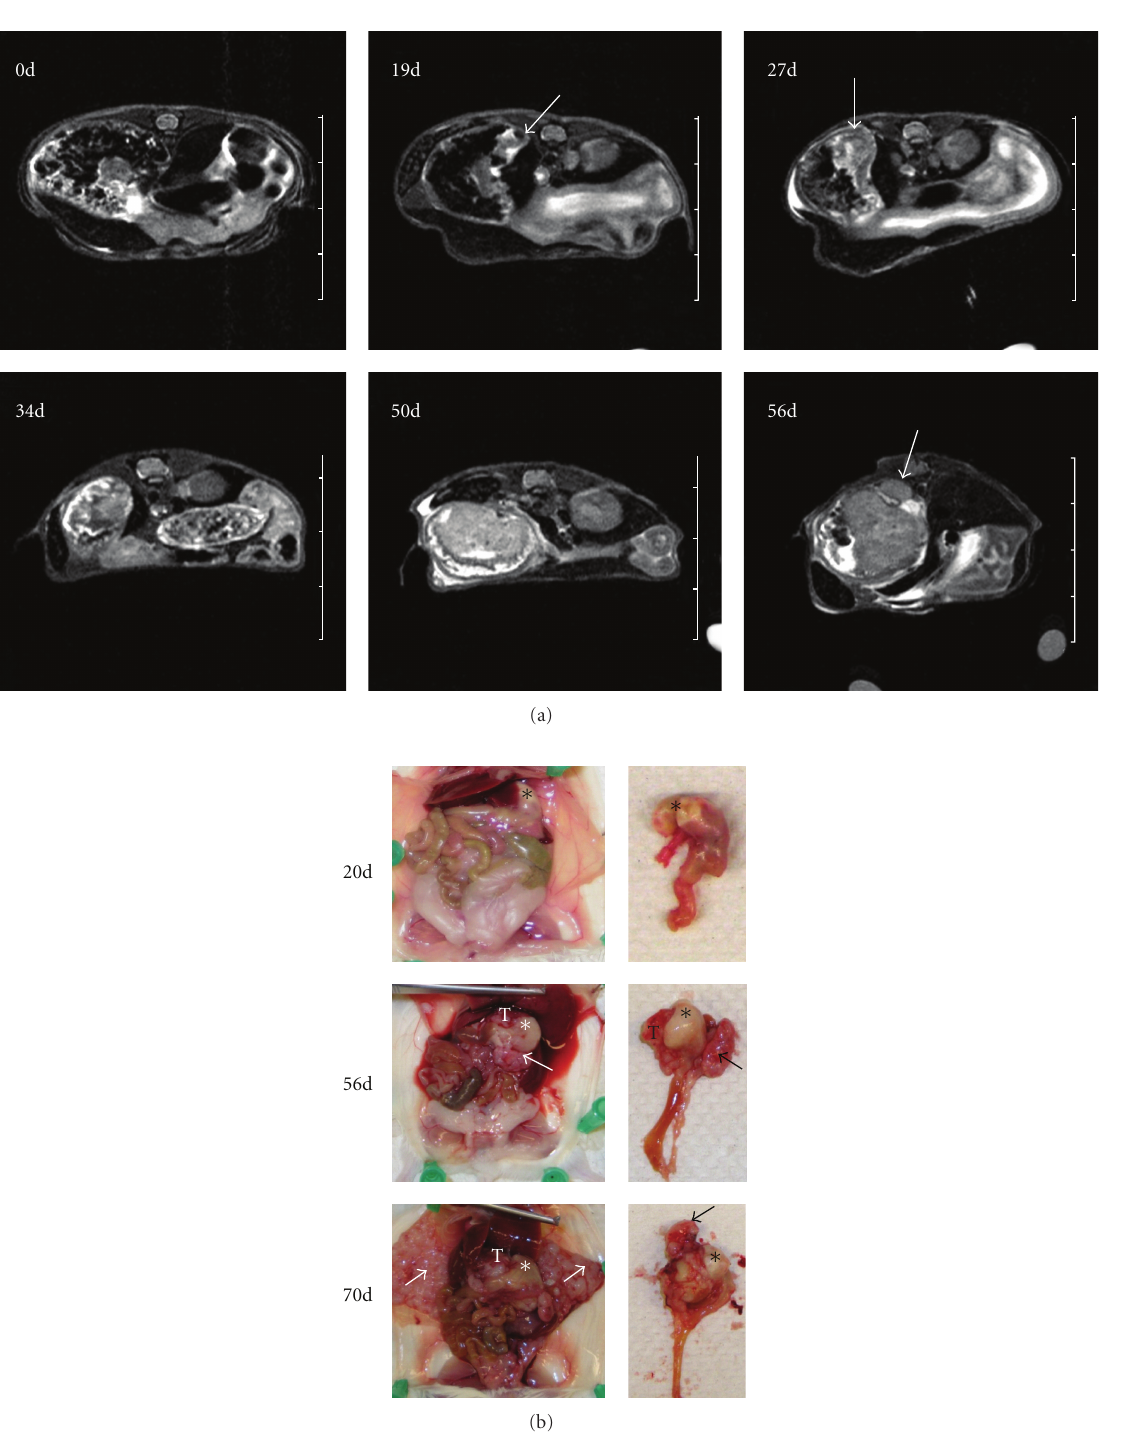
Figure 1: PPAR δ agonist GW501516 induces gastric tumorigenesis after DMBA treatment. (a) In vivo axial T2-weighted abdominal MR Images showing gastric tumor progression at the indicated time points; d , number of days animals were administered the GW501516- supplemented diet. Tumor growth initiated in the forestomach ( arrow) at 19 days, rapid tumor growth between 27 and 50 days, and tumor invasion through the stomach ( arrow ) at 56 days. (b) Gross morphology of tumors at indicated time points. Forestomach ( ∗ ), gastric tumors ( T ) and metastases ( arrows ) are indicated. Tumor is confined within the stomach at 20 days. Invasion of primary tumor through the stomach ( T ) and metastases ( arrow ) were evident at 56 days, and intraperitoneal metastases along the abdominal wall ( white arrows ) occurred at 70